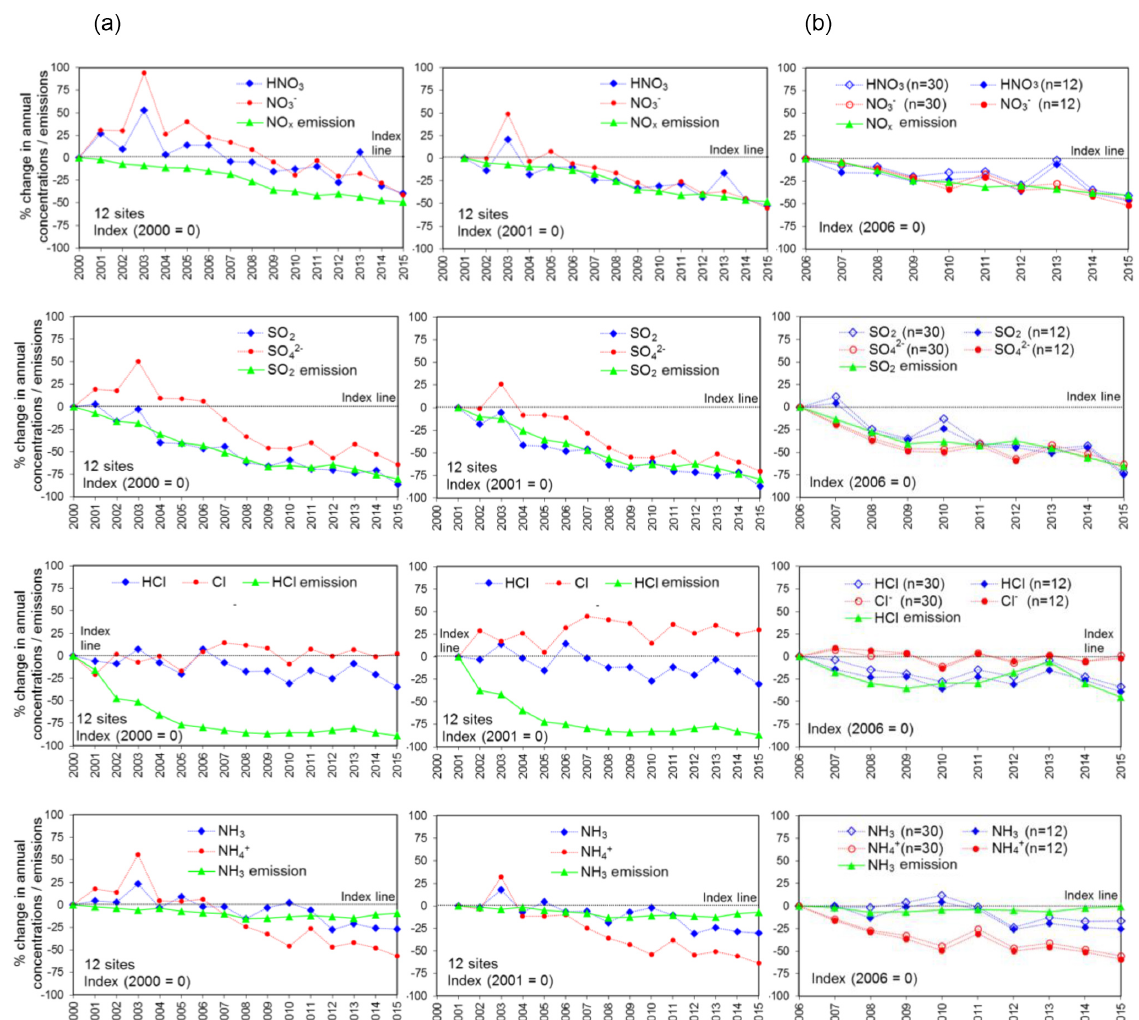
Figure 14. Relative trends in UK emissions (NAEI, 2018) and in annually averaged gas and particulate concentrations from the UK AGANet and UK National Ammonia Monitoring Network (NAMN, Tang et al., 2018) for (a) the original 12 sites for the 16 year period from 2000 to 2015, and (b) expanded 30 sites compared with the original 12 sites for the 10 year period from 2006 to